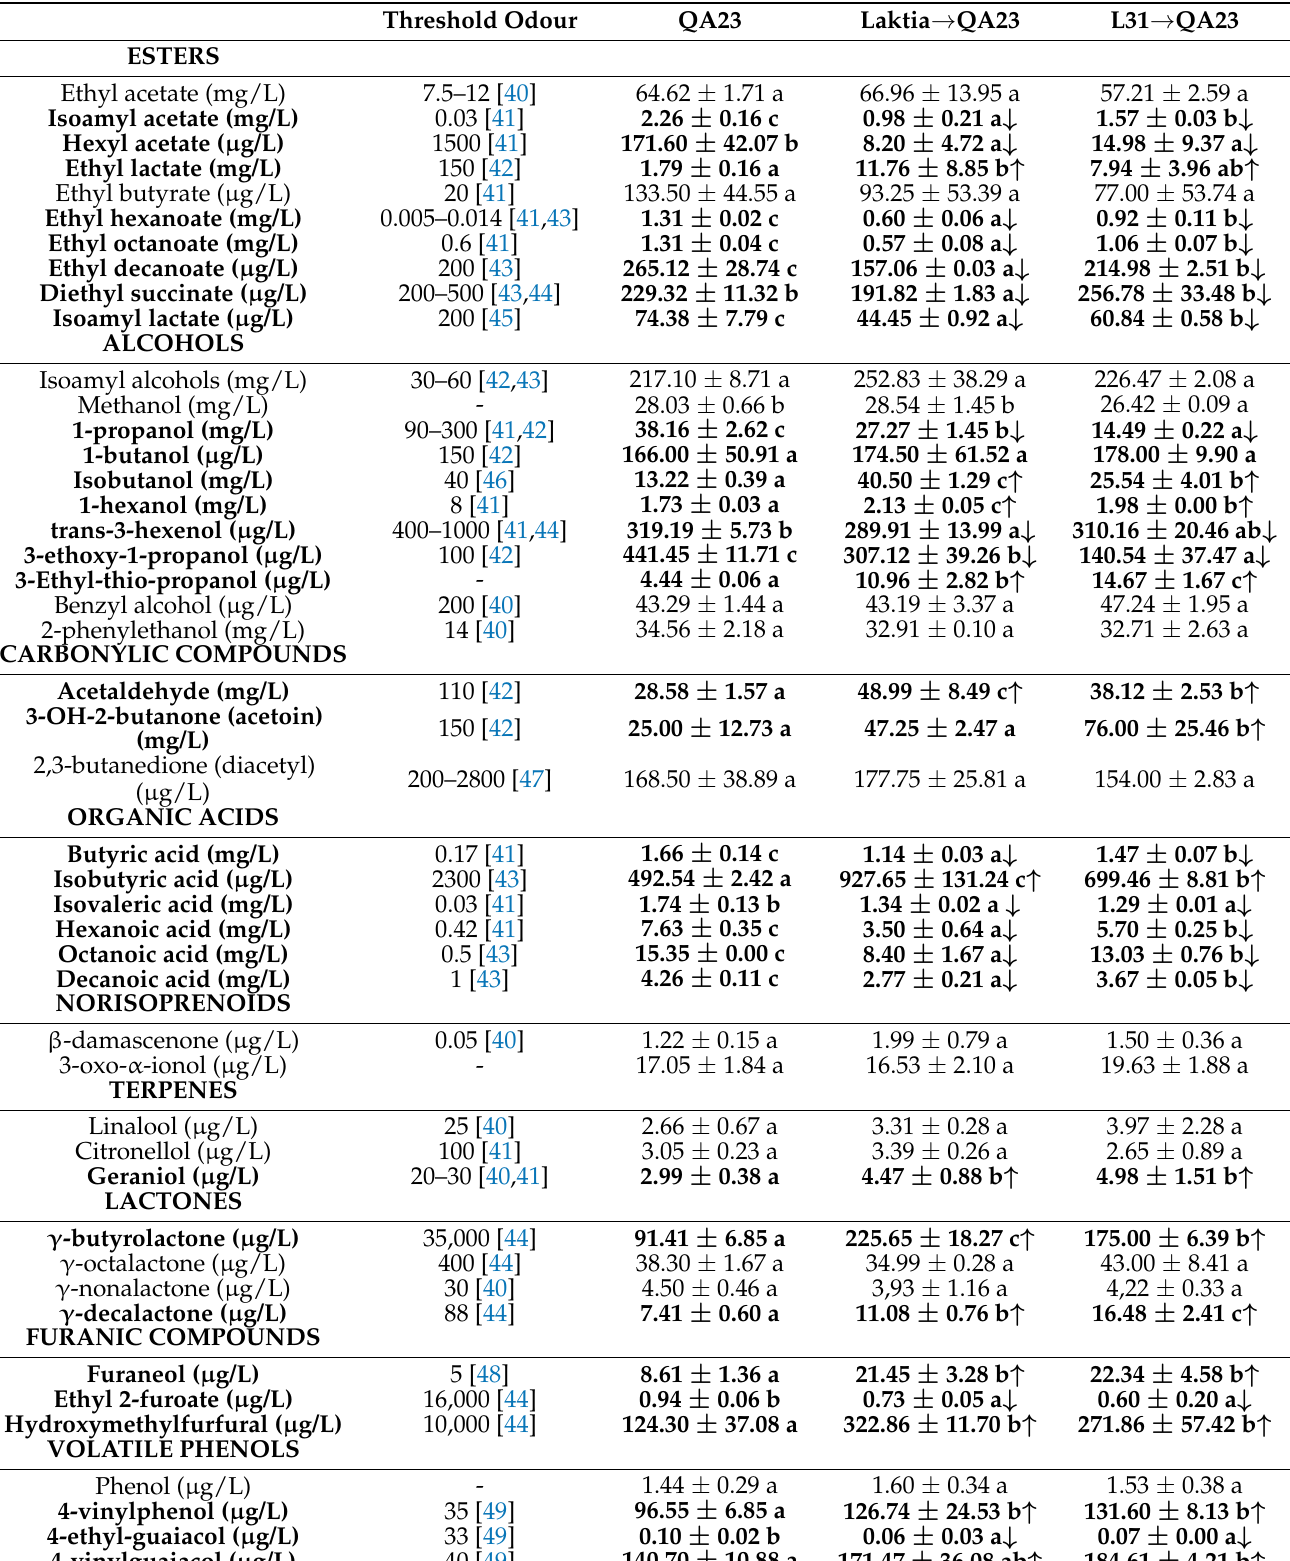
Table 3. Concentration (mg/L and µ g/L) of the different volatile compounds analysed at the end of fermentation in the different inoculations with their respective odour thresholds. Different letters in the same row indicate statistically significant differences according to the Student–Newman–Keuls (S–N–K) test. α =